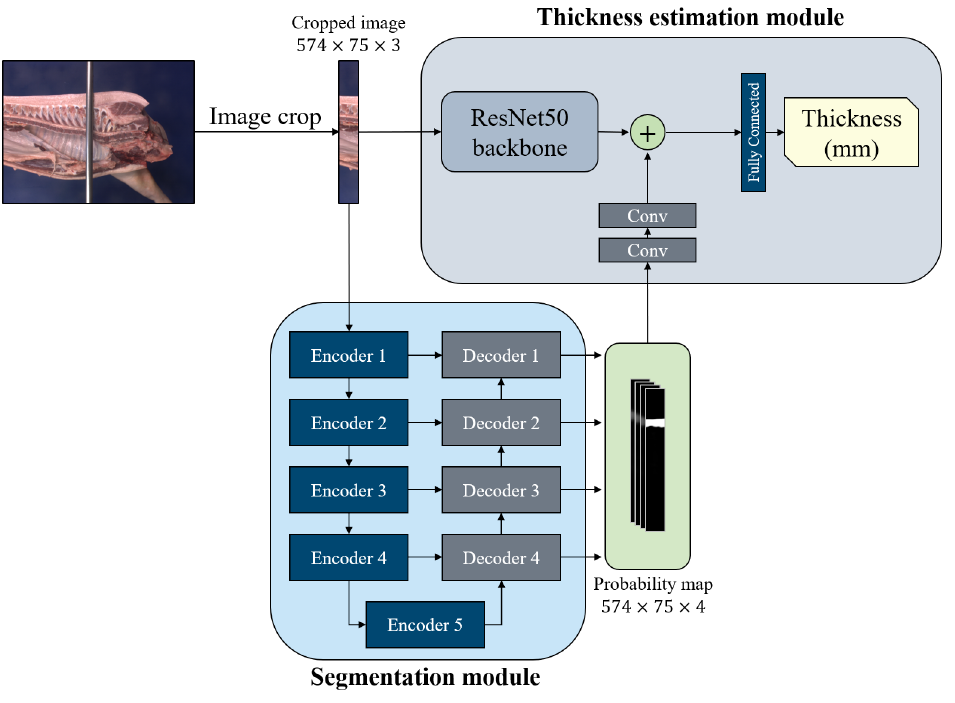
Figure 3. Architecture of